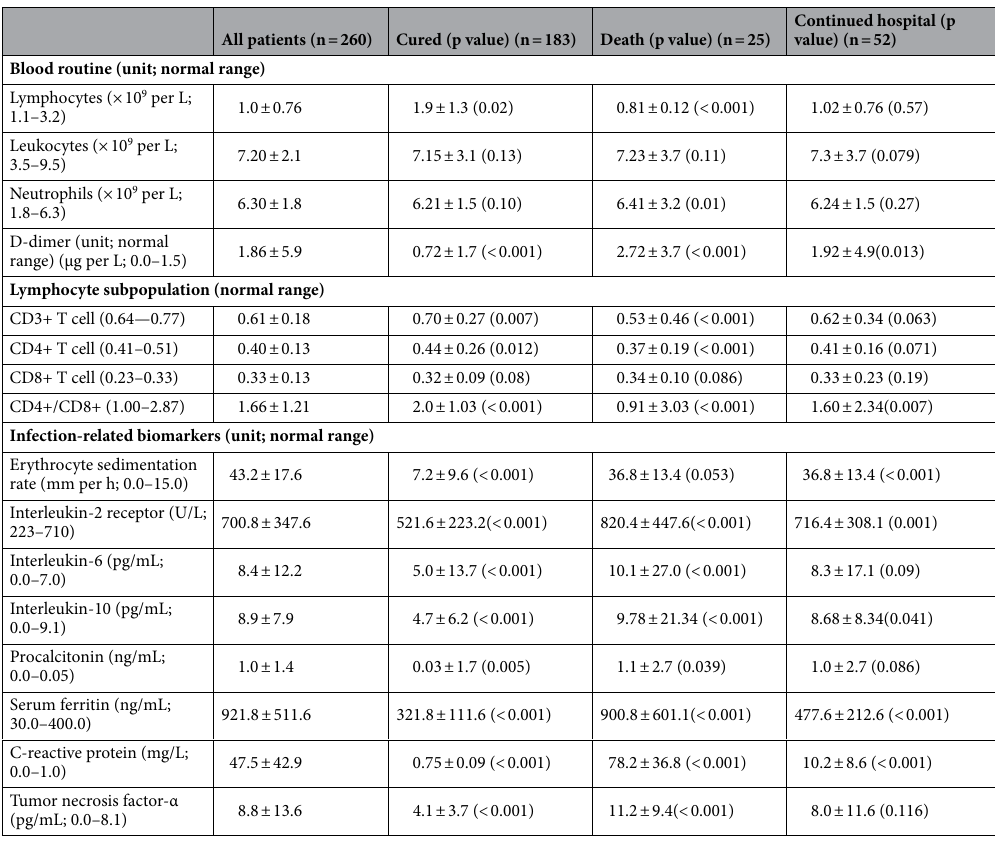
Table 4. Laboratory data between admission, prognosis and outcome of